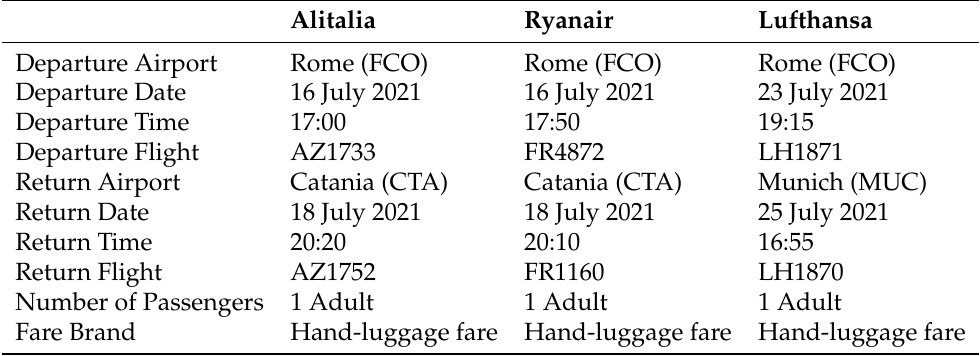
Table 1. Itineraries of the